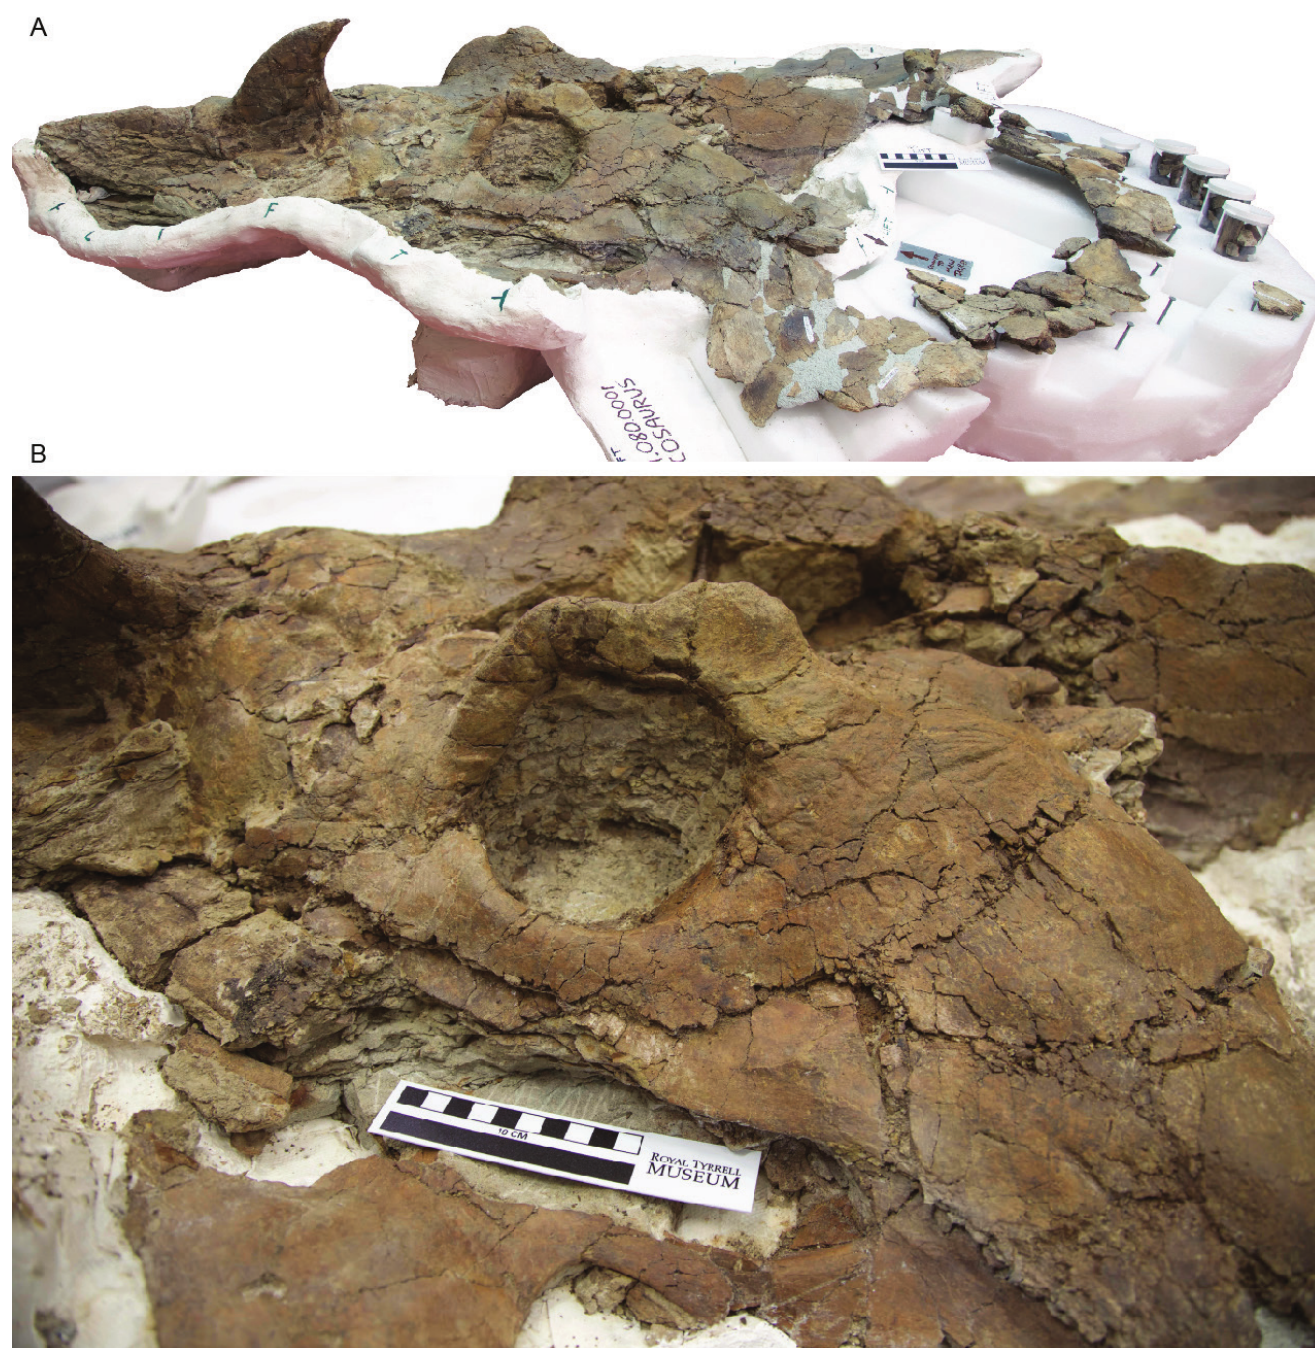
Figure 5. Photographs of the left side of TMP 2009.080.0001, a subadult of Styracosaurus albertensis , showing the overall skull (A) and an inset of orbital region (B). Scale bars = 10